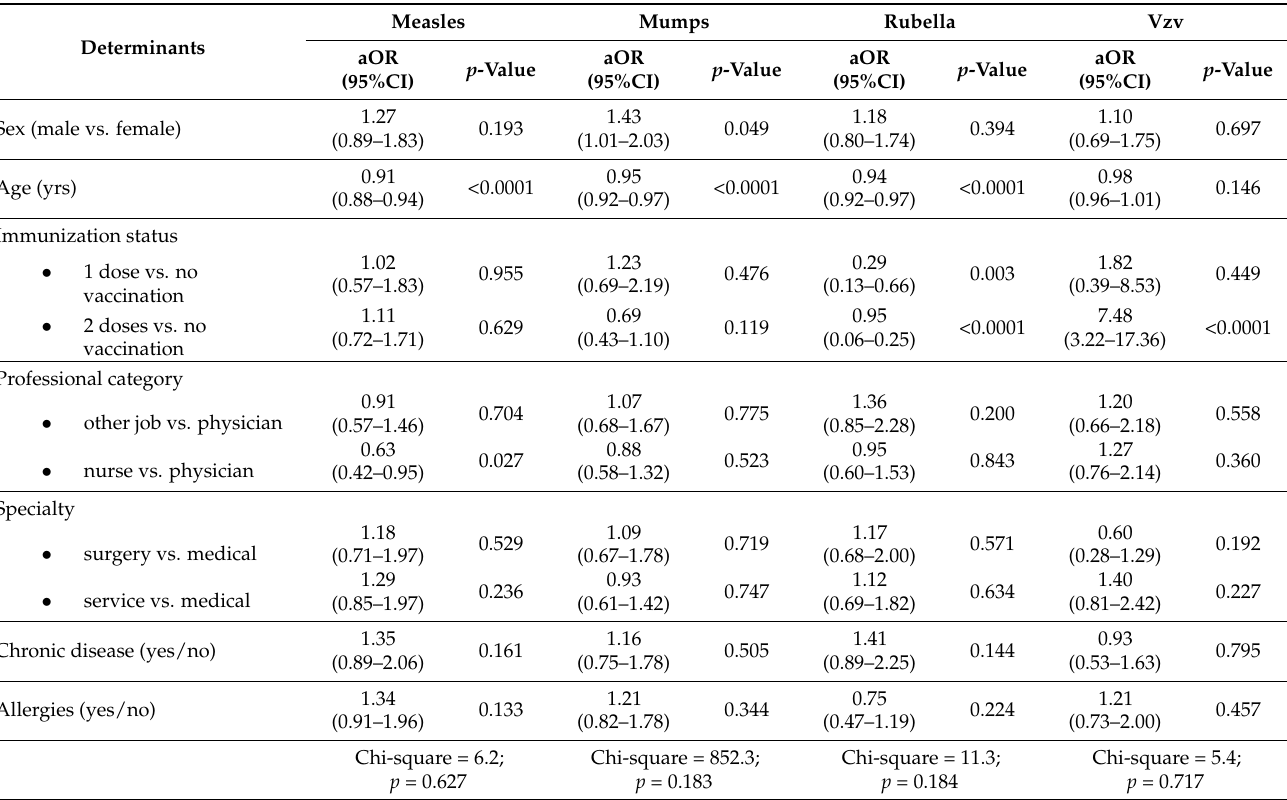
Table 3. Analysis of the determinants of susceptibility to serological evaluation in multivariate logistic regression models.